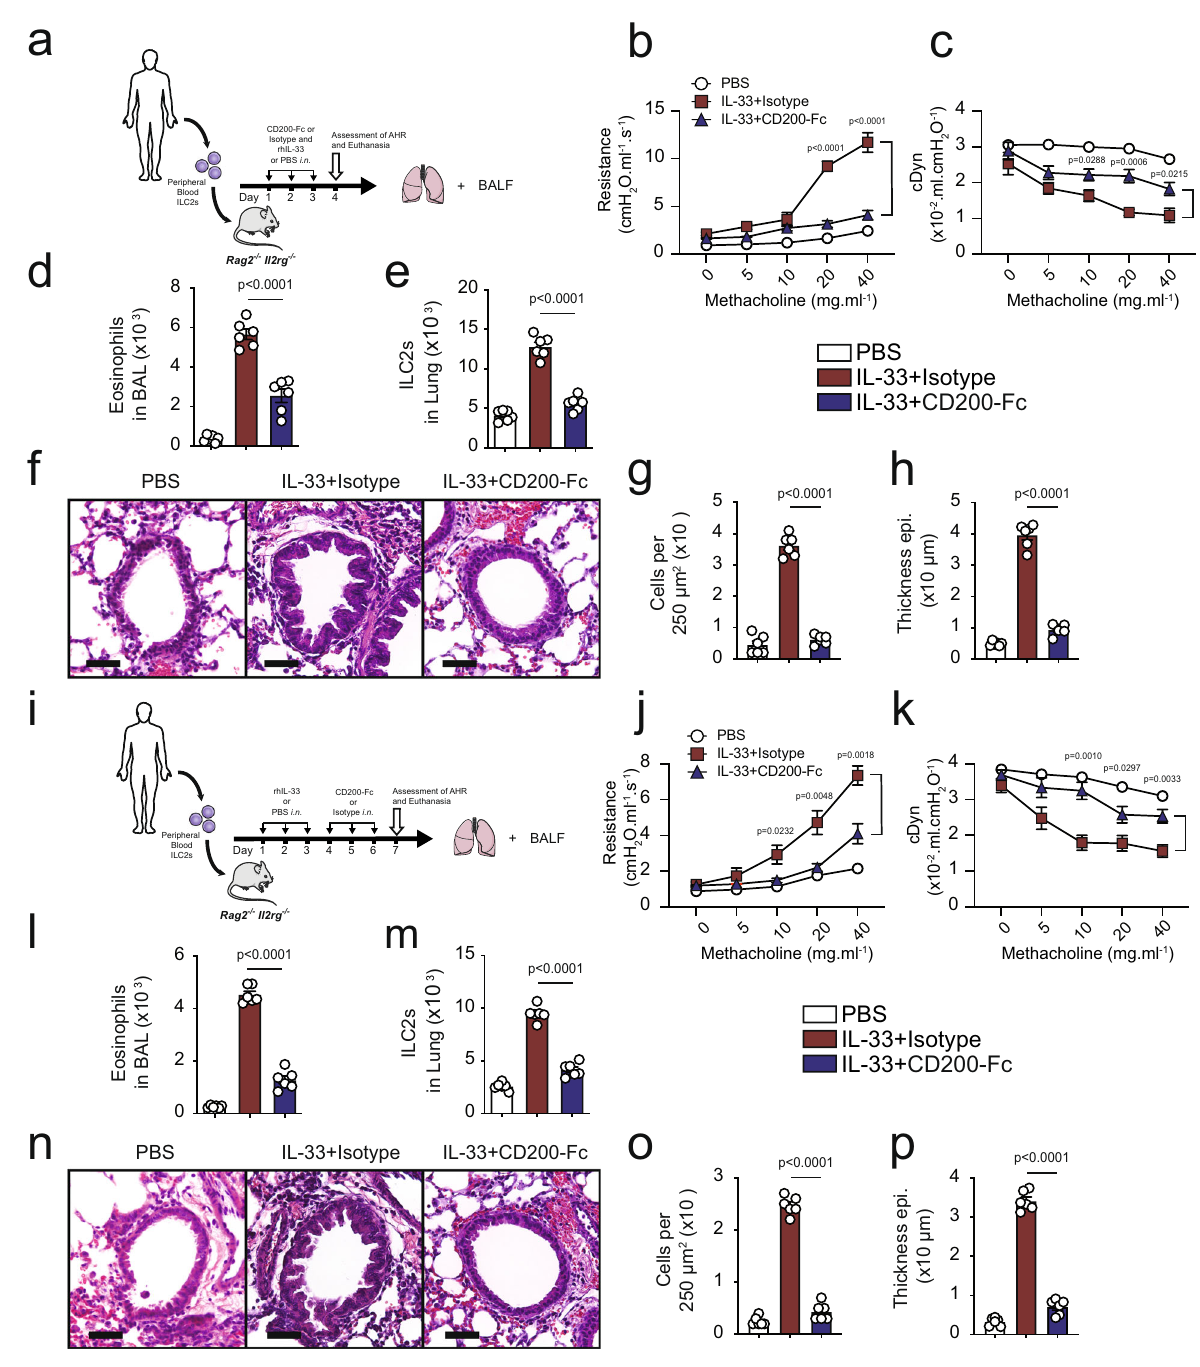
Fig. 7 CD200R engagement ameliorates human ILC2-mediated AHR. a Human peripheral ILC2s from healthy donors were puri fi ed via FACS and cultured with rhIL-2 (20 ng/ml) and rhIL-7 (20 ng/ml) for 48 h, and then adoptively transferred into Rag2 − / − Il2rg − / − mice. Additionally, the mice were challenged with either rhIL-33 (1 µ g) or PBS intranasally (i.n.) and treated with CD200-Fc or isotype control on days 1, 2, and 3. Measurement of lung function and analysis of BAL fl uid followed on day 4, as shown in the timeline, n = 6 mice. b , c Line graphs show lung resistance and dynamic compliance in response to increasing doses of methacholine. d The numbers of eosinophils in the BAL. e The numbers of human ILC2s in the lungs. f Histological images of the lungs, and g corresponding quanti fi cations of cell numbers, and h thickness of epithelium. Scale bars = 50 μ m. i Human peripheral ILC2s from healthy donors were puri fi ed via FACS and cultured with rhIL-2 (20 ng/ml) and rhIL-7 (20 ng/ml) for 48 h, and then adoptively transferred into Rag2 − / − Il2rg − / − mice. The mice were then challenged with either rhIL-33 (1 µ g) or PBS intranasally (i.n.) on days 1, 2, and 3. Subsequently, the mice were treated with CD200-Fc or vehicle control on days 4, 5, and 6. The lung function, BAL fl uid and lung tissue were analyzed on day 7, n = 6 mice. j Lung resistance, and k dynamic compliance. l BAL eosinophilia and m pulmonary ILC2s are shown as bar graphs. n Histological images of the lungs, and o , p corresponding quanti fi cations. Scale bars = 50 μ m. Data are shown as means ± SEMs and are representative of three individual experiments. Statistical analysis, one-way ANOVA followed by Tukey post-hoc tests. Human, mouse and lung images are sourced through an open access license from Servier Medical